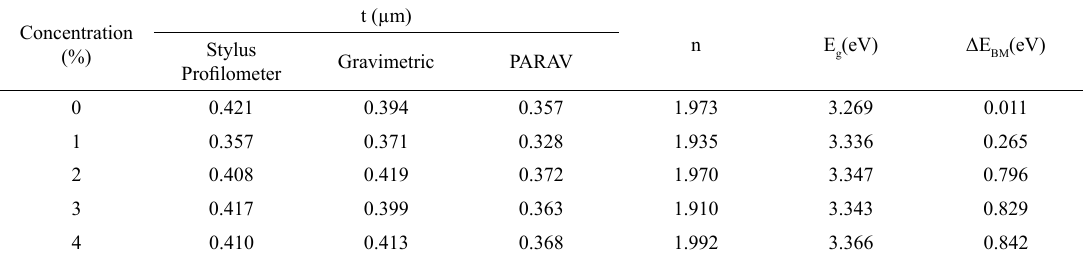
Table 3. Estimated values of film thickness (t) by using Profilometer, gravimetric method and using PARAV software, refractive index at 633nm (n), Energy gap (E ) and Burstein-Moss energy shift (ΔEBM) for the thin films of B-N codoped ZnO with various B concentrations. g Concentration (%)